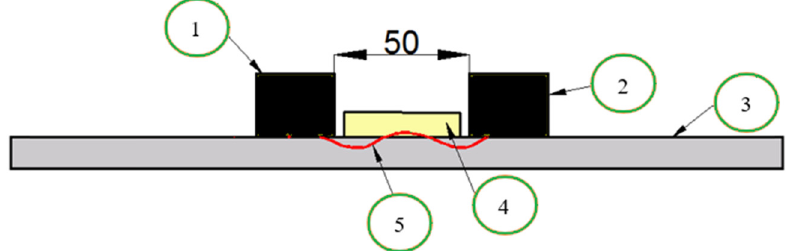
Figure 2: Scheme for conducting studies of the constitution and degradation stage of the adhesive bond between coating and substrate by ultrasonic surface wave; 1 – transmitting head, 2 – receiving head, 3 – substrate, 4 – coating and 5 – ultrasonic - surface